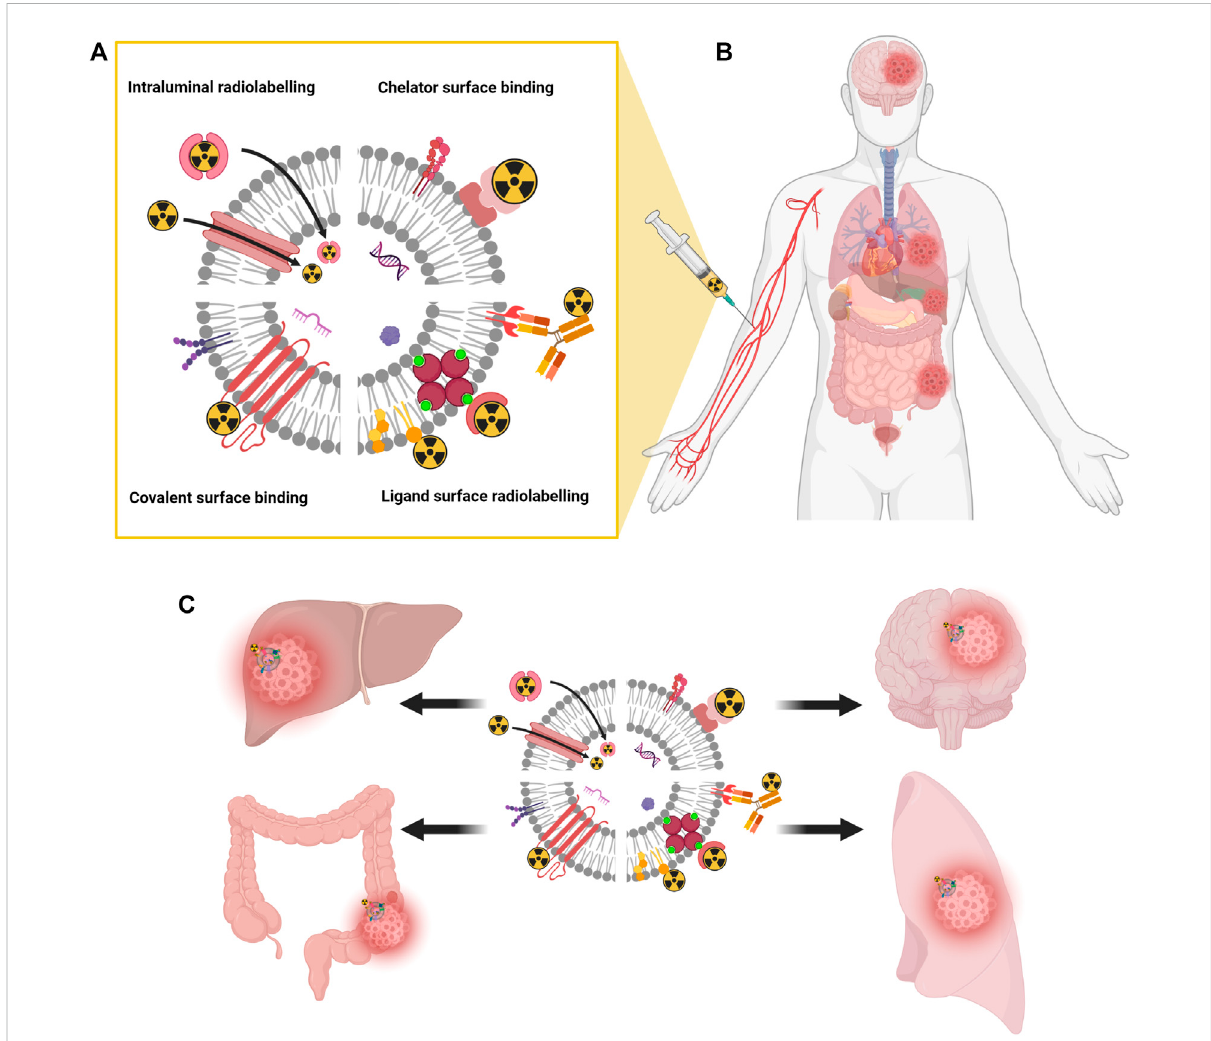
FIGURE 2 Schematic representation of different EVs radiolabeling methods. Surface radiolabeling, covalent binding, and intraluminal radiolabeling (A) . RadiolabeledEVsinjectedintoapatientbloodstream (B) deliversradiationtherapyanddrugsspeci fi callyanddirectlytodiseasesites (C) .Createdwith